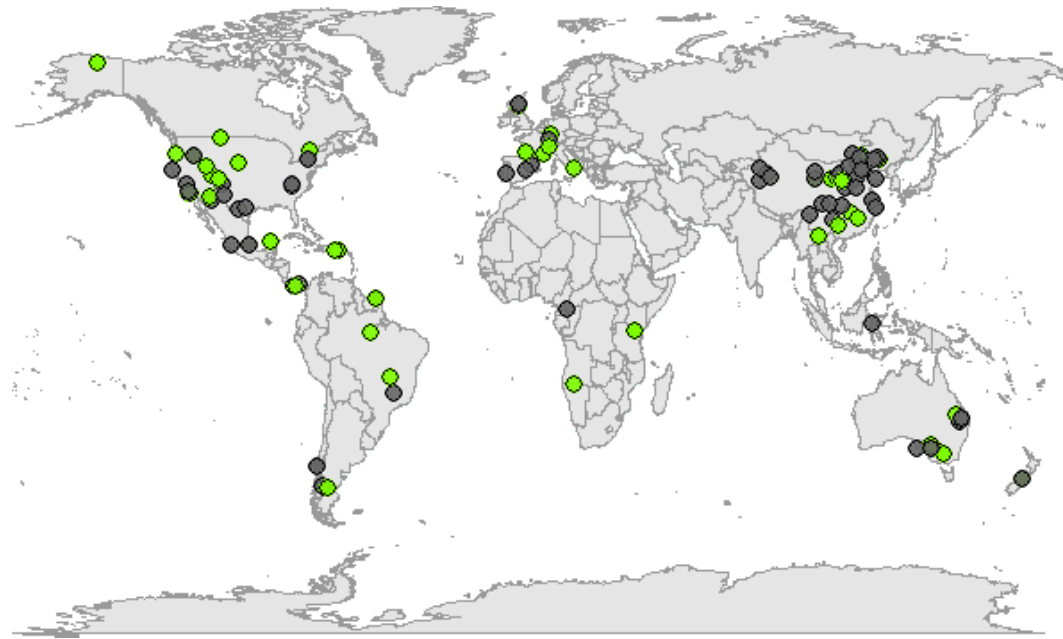
Figure 3. Map showing the sampling location for the study sites (data from experiments under controlled conditions excluded). Green symbols depict studies where both line conditioned excess (LC-excess) and soil water excess (SW-excess) were negative for at least one